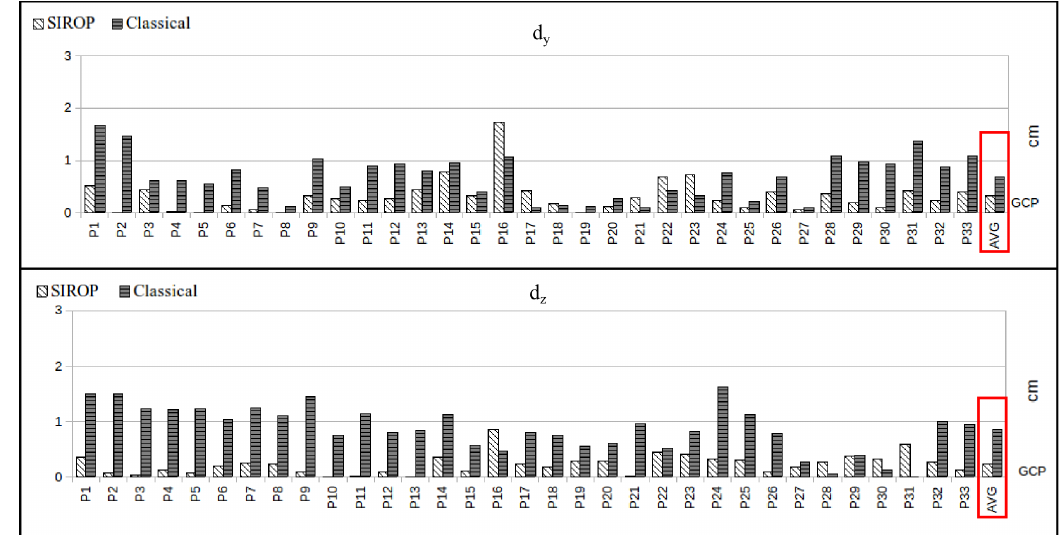
Figure 25. Comparison with GCPs—the Hallway dataset. From the top: Euclidean distance, in X, in Y, in Z. In the red frame: average distance value.